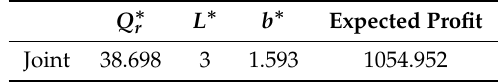
Table 3. Optimal solutions for the traditional system.